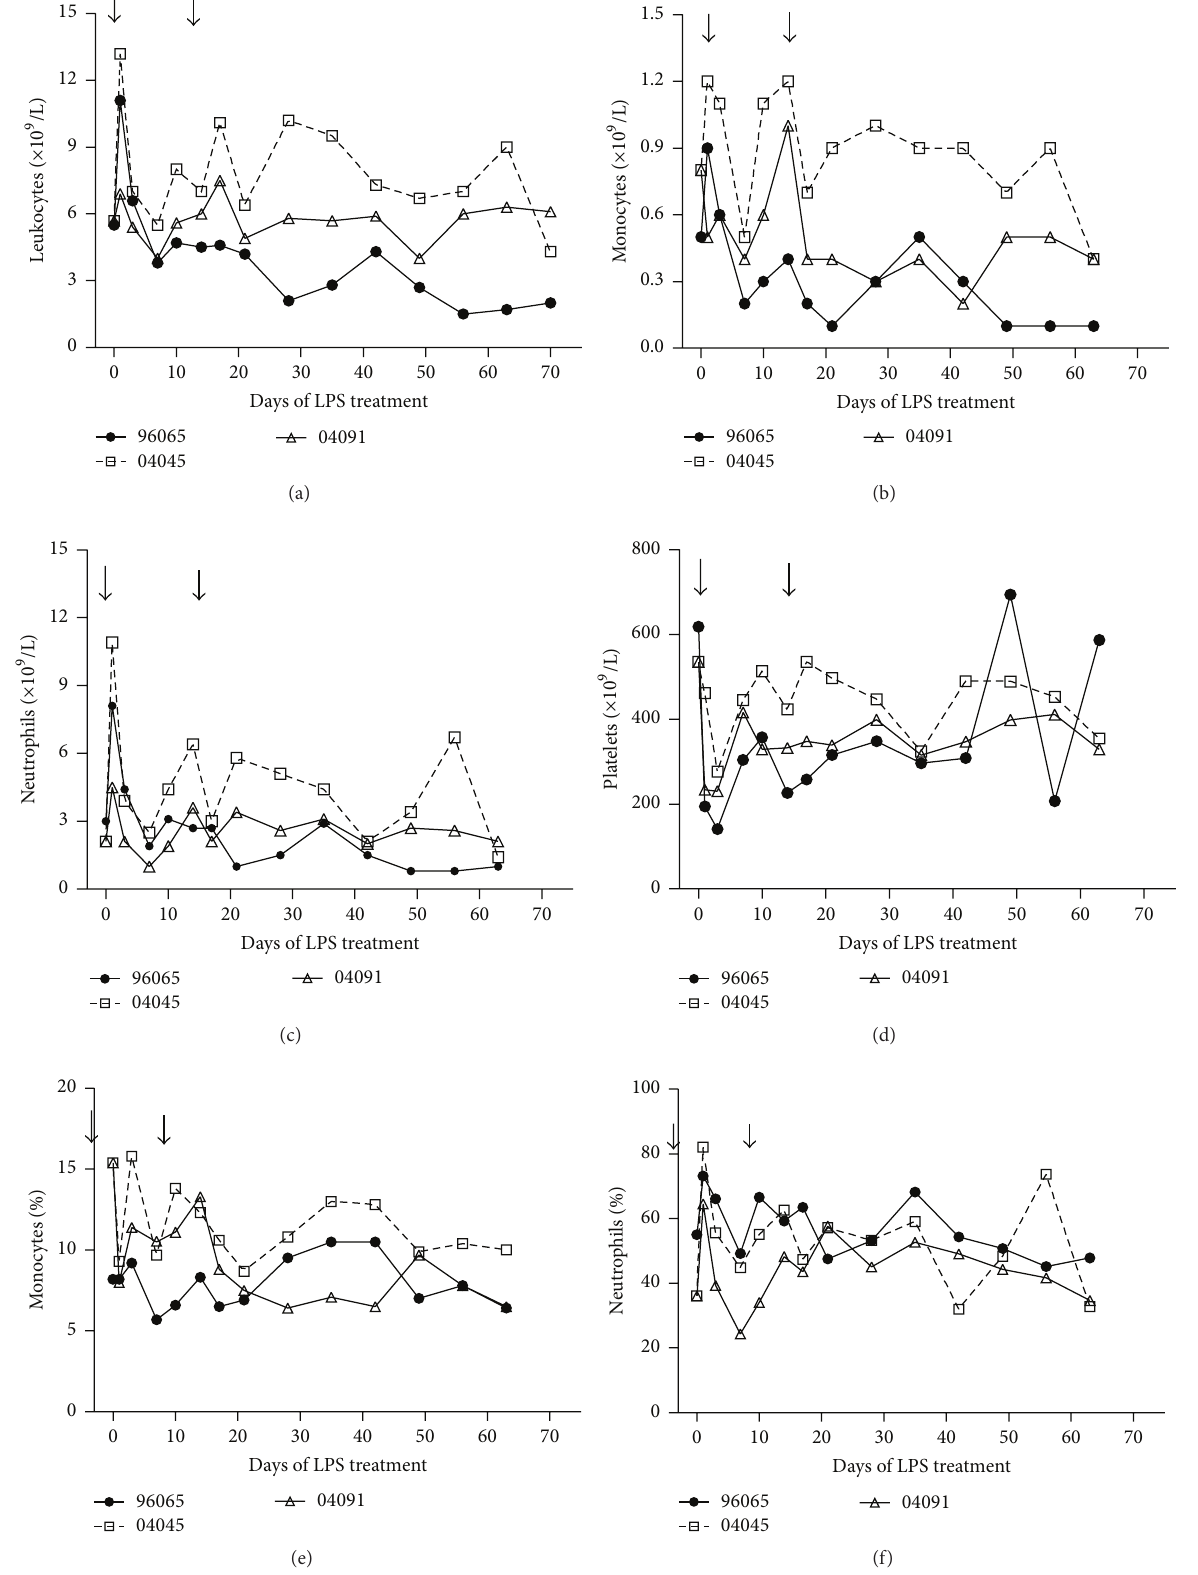
Figure 7: Hematological changes associated with LPS administration in Ch-RMs. Levels of leukocytes (a) were increased in LPS-treated Ch-RMs with concomitant increases in monocytes (b) and neutrophils (c). Platelet counts (d) were decreased after LPS stimulation. The percentages of monocytes (e) and neutrophils (f) were increased in